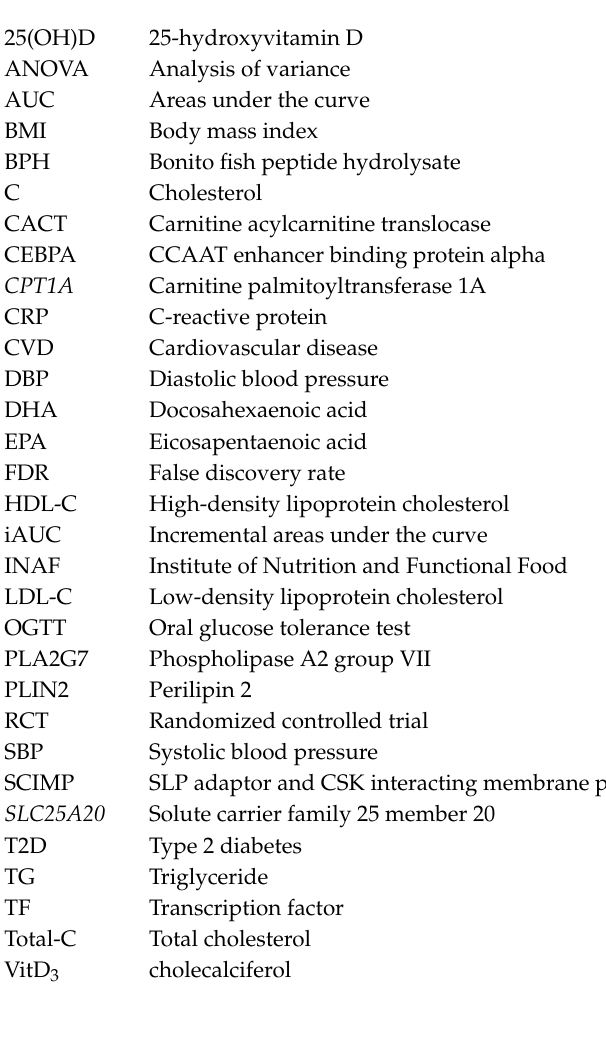
hydrolysate treatment: VitD, vitamin D 3 treatment. Table S1. Di ff erences in metabolic parameters between the expression subset and the full cohort. Table S2. Gene expression analysis for transcripts showing di ff erential gene expression in at least one treatment. Table S3. Biological functions identified from the list of di ff erentially expressed transcripts following VitD 3